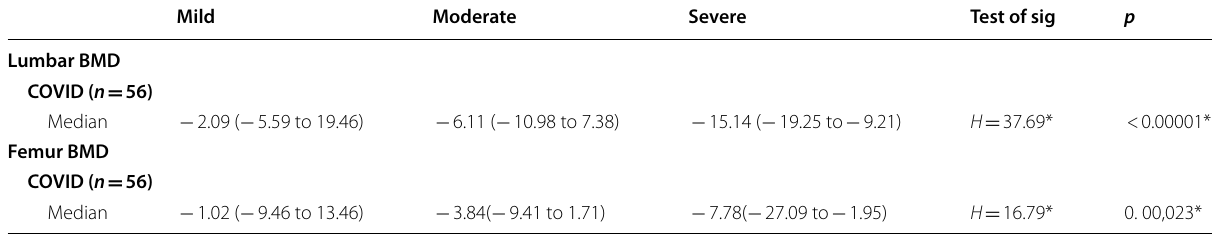
Table 5 Comparison between the three subgroups (according to severity) of COVID infection regarding percentage of change in bone mineral density (BMD) at femur and lumbar spine after 9